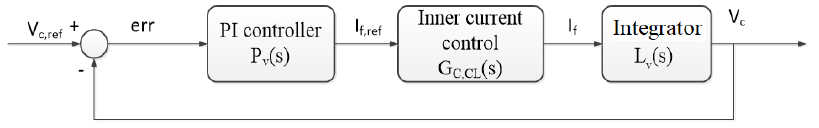
Figure 5. Block of the outer voltage PI controller.